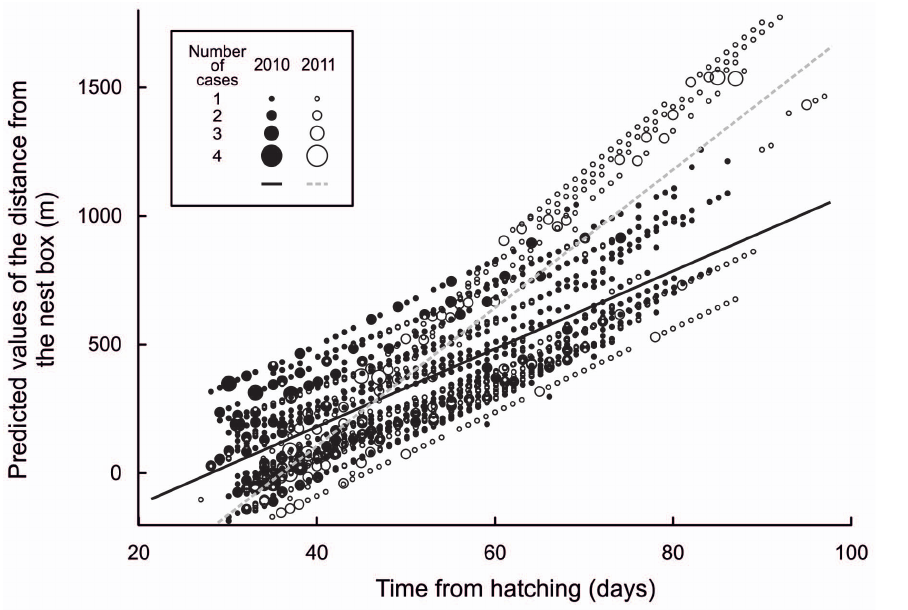
Figure 1. Predicted values of the distance from the nest box for 2010 (filled circles) and 2011 (open circles) plotted against the owlets age from hatching.